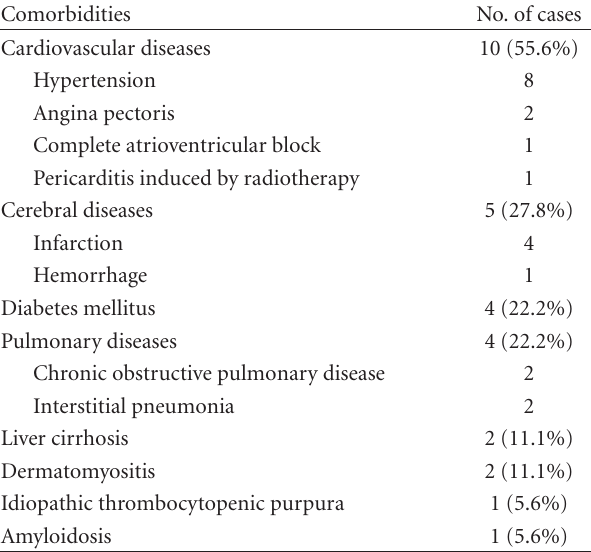
Table 1: Preoperative comorbidities in patients with additional